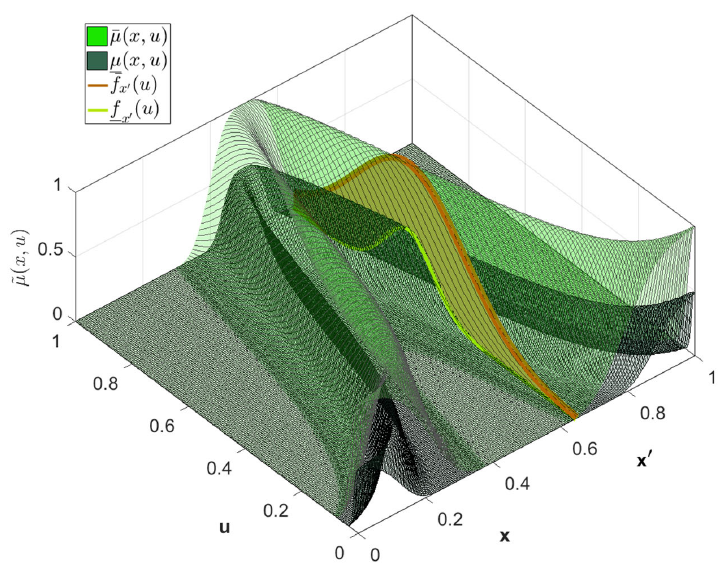
Figure 4. Gaussian type ‐ 3